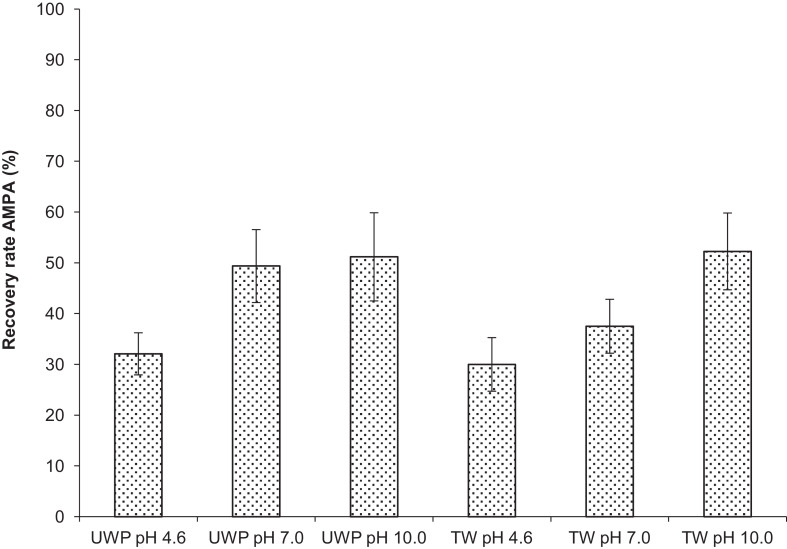
Influence of the pH on the recovery of 10 mg L−1 AMPA without additional 1000 mg L−1 CH3COONH4.